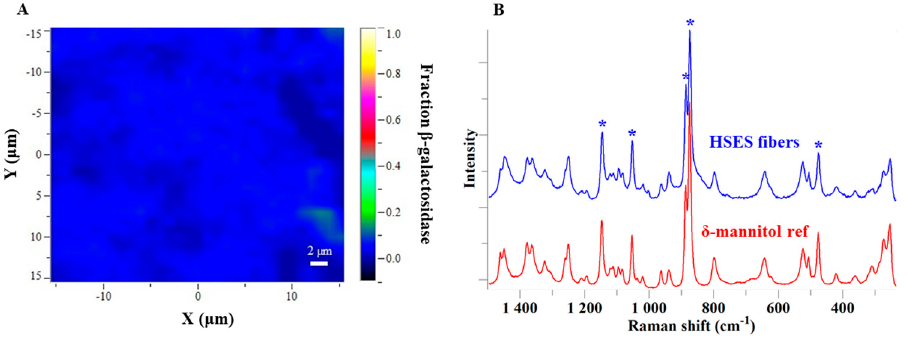
Figure 7. ( A ) Homogeneity study of β -galactosidase in the electrospun fibers by Raman mapping; ( B ) Raman spectra of the ground electrospun fibers and δ -mannitol (characteristic peaks marked with *).